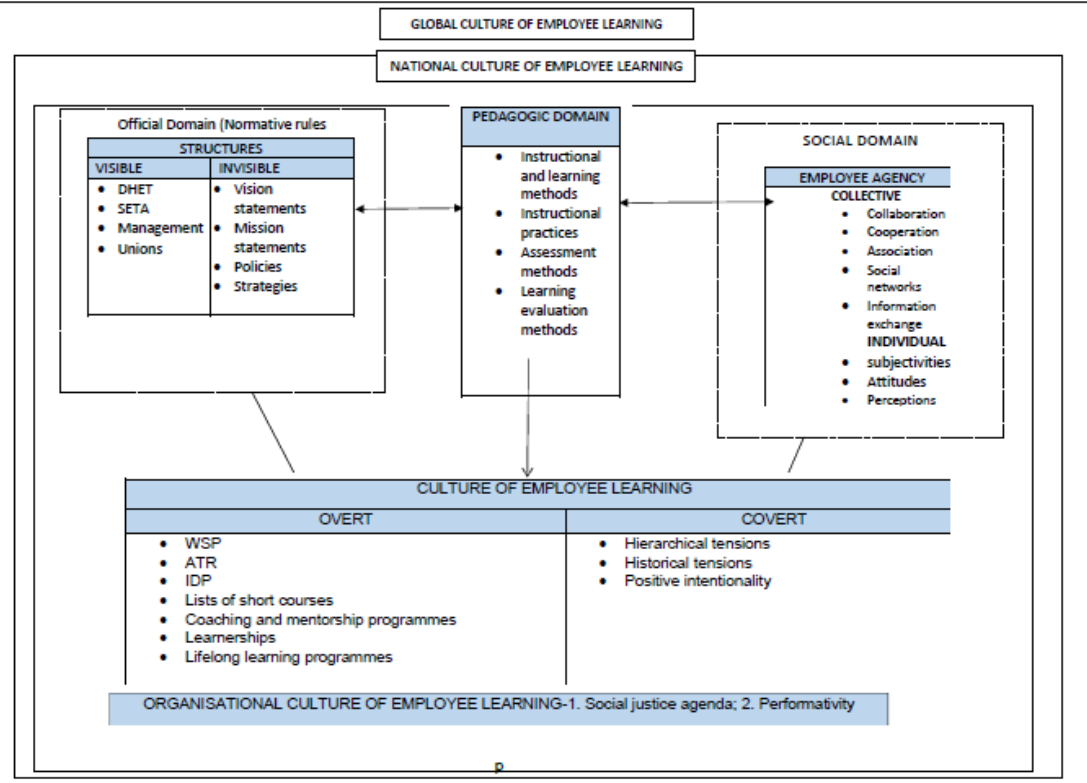
Figure 2: Domains of employee learning at a South African university (Adapted from Mavunga and Cross,